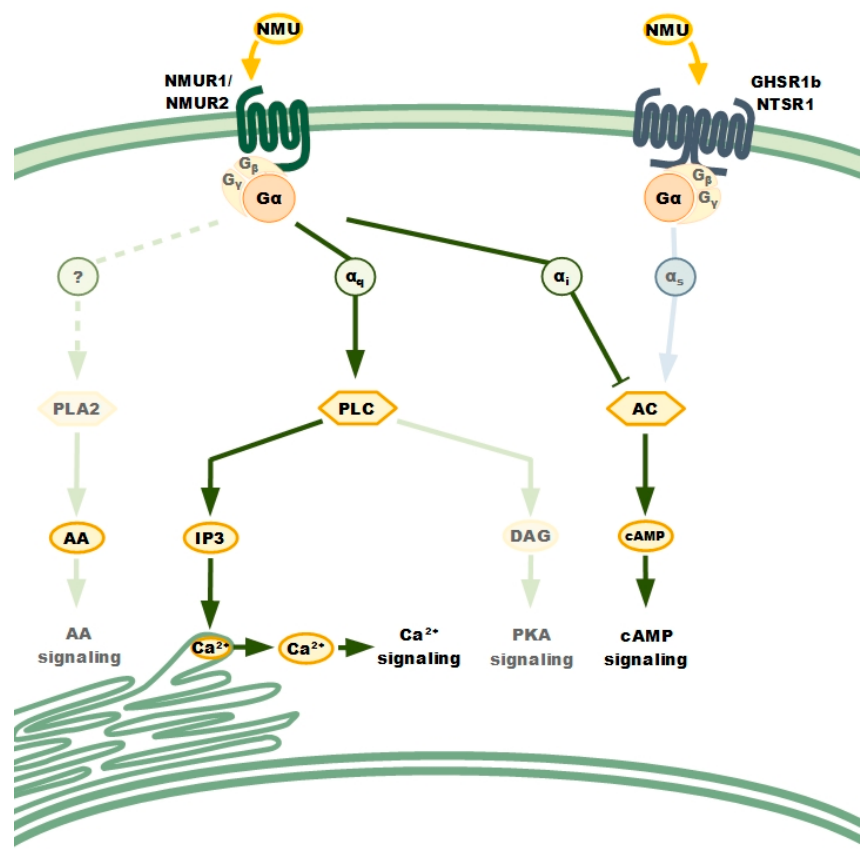
Figure 1. The current paradigm of neuromedin U signalling.